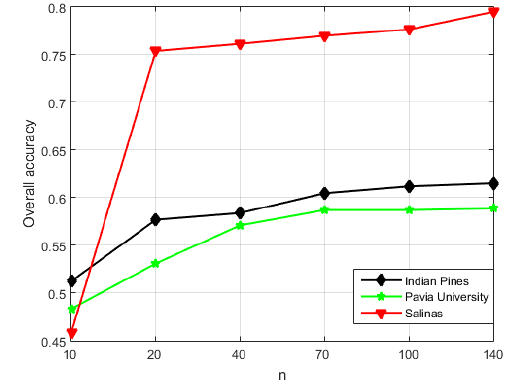
Figure 9. Performance of the proposed method with respect to n .